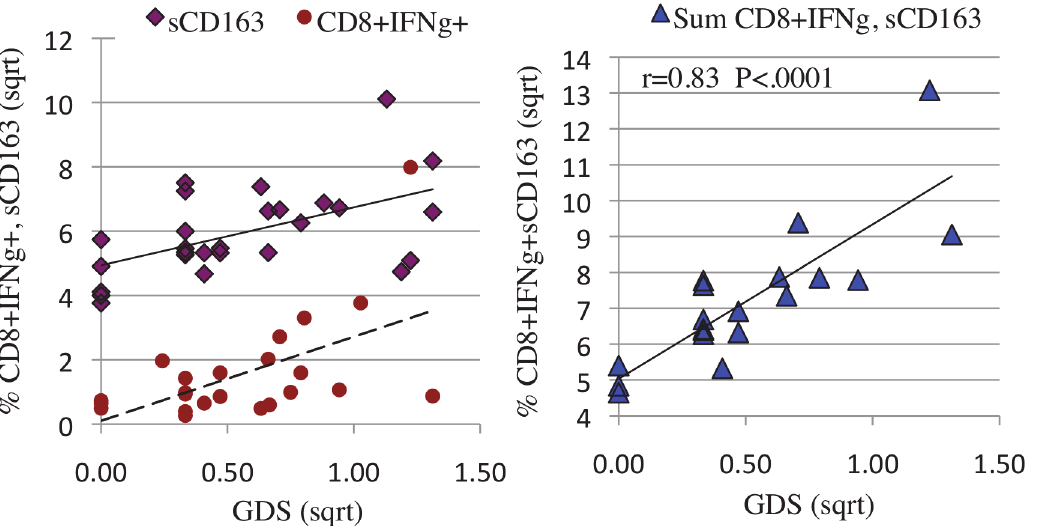
Fig 5. CD8+IFN γ + expression and soluble CD163 in CSF represent two significant and independent correlates of NCI (5a). The composite association is stronger than either alone (5b). a: The percentage of constitutive CSF CD8+IFN γ expression (solid circles, dotted line, r = 0.59 p = 0.004) and soluble CSF CD163 (open diamonds, solid line, r = 0.42, p = 0.004) were plotted as a function of neurocognitive global deficit score (GDS). b: The percentage of constitutive CSF CD8+IFN γ expression and pg of soluble CSF CD163 were summed for visits at which both values were available and the composite score plotted as a function of neurocognitive GDS (solid triangles, r = 0.83, p < 0.0001). Expression levels and GDS were square root